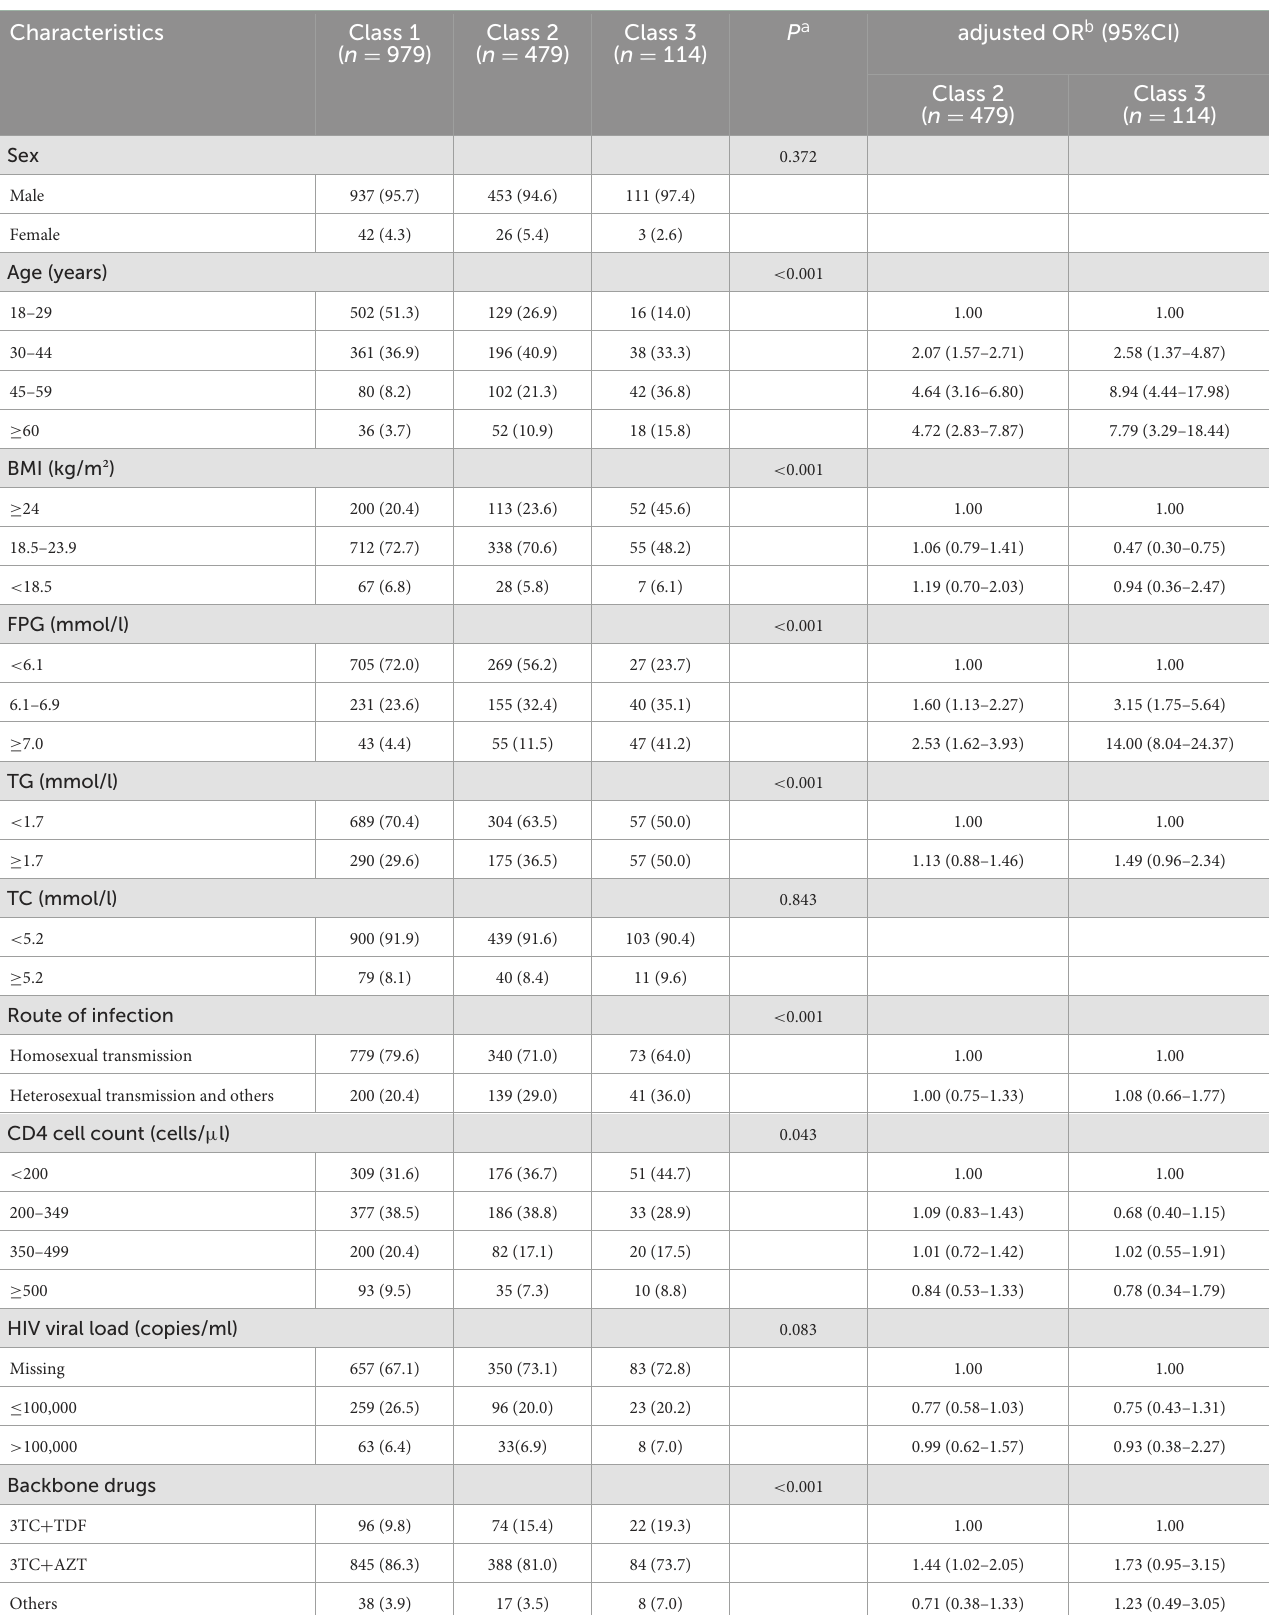
TABLE 2 Baseline characteristics of participants among three FPG trajectory